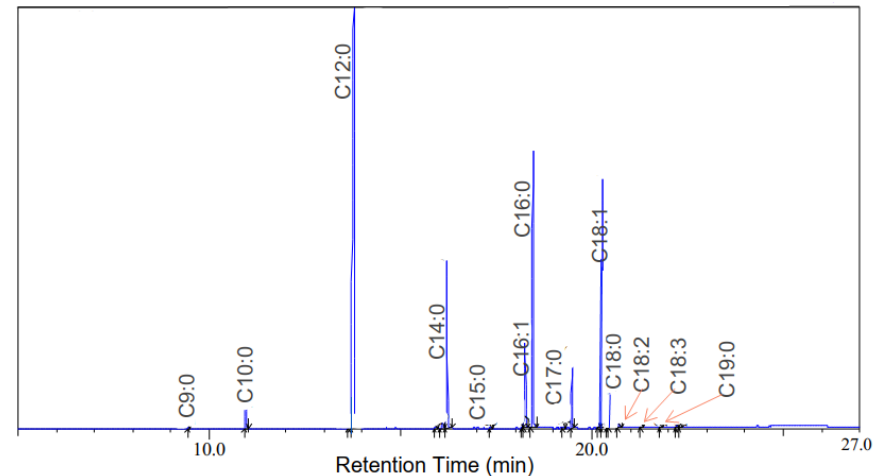
Figure 11. GCMS chromatographs of fatty acids and FAME derives from BSFL biodiesel.